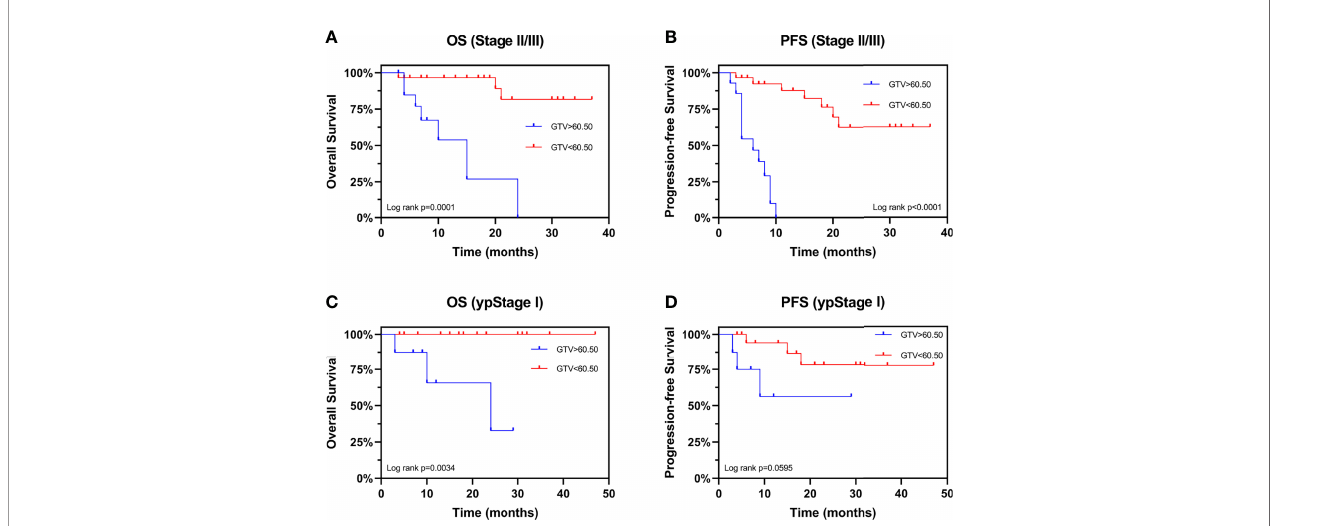
FIGURE 5 | Kaplan-Meier Curves for overall survival and progression-free survival strati fi ed by GTV. Curves are shown for overall survival strati fi ed by GTV in patients with (A) stages II and III and (C) ypStage I Curves are shown for progression-free survival strati fi ed by GTV in patients with (B) stages II and III and (D) ypStage I. GTV, gross tumor volume; ypStage, post-neoadjuvant pathological stage.